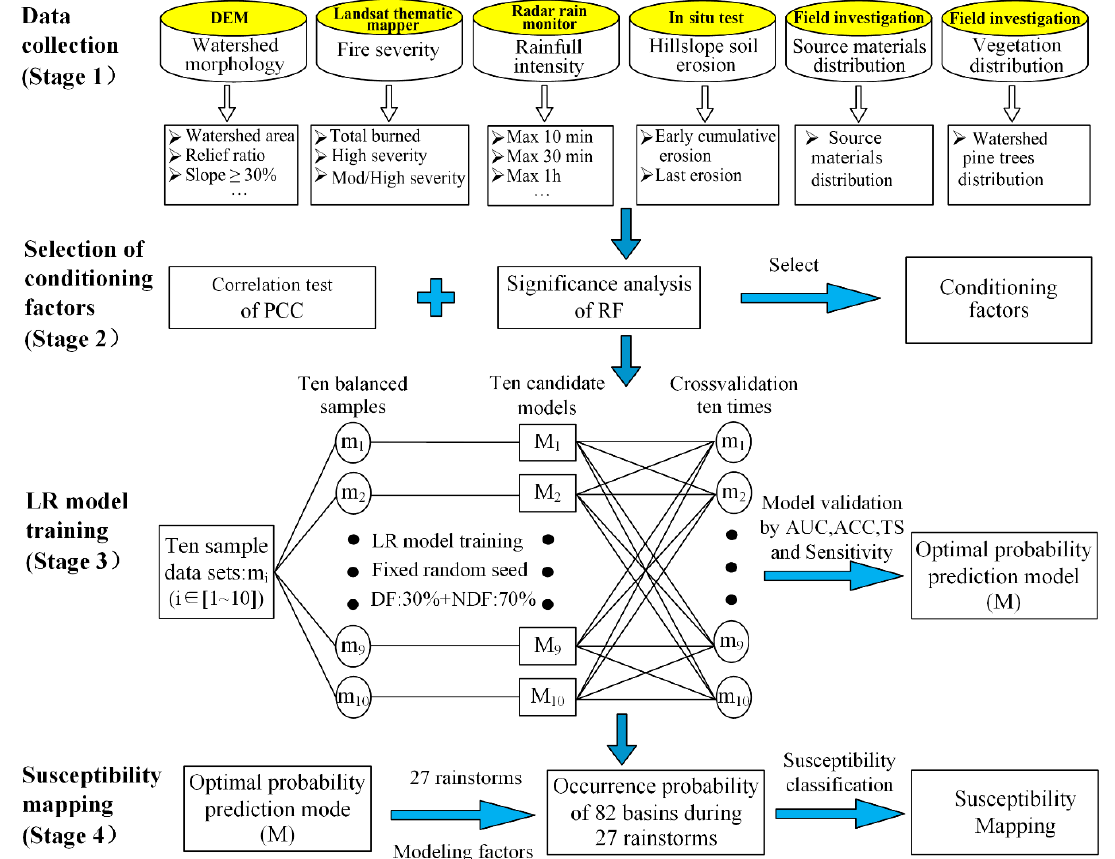
Figure 5. The flowchart of this study.